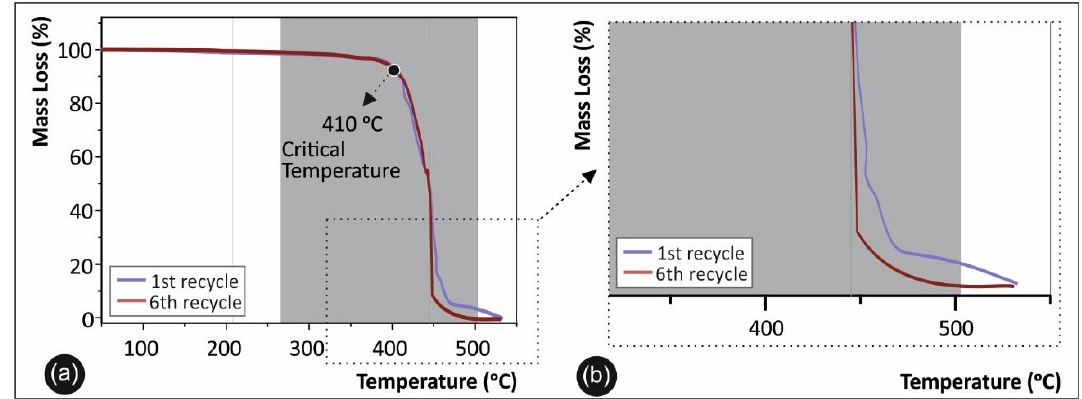
Figure 8. ( a ) TGA graphs for pure PA12 1st recycling course versus 6th recycling course; ( b ) magnified TGA temperature window for the material’s thermal degradation region.